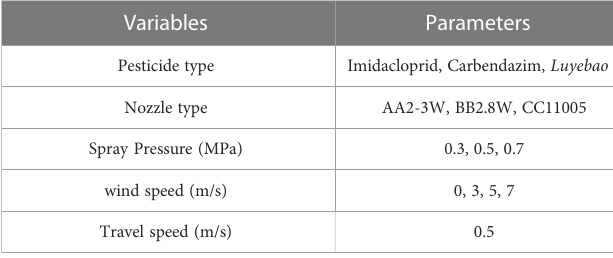
TABLE 1 Experimental variables and